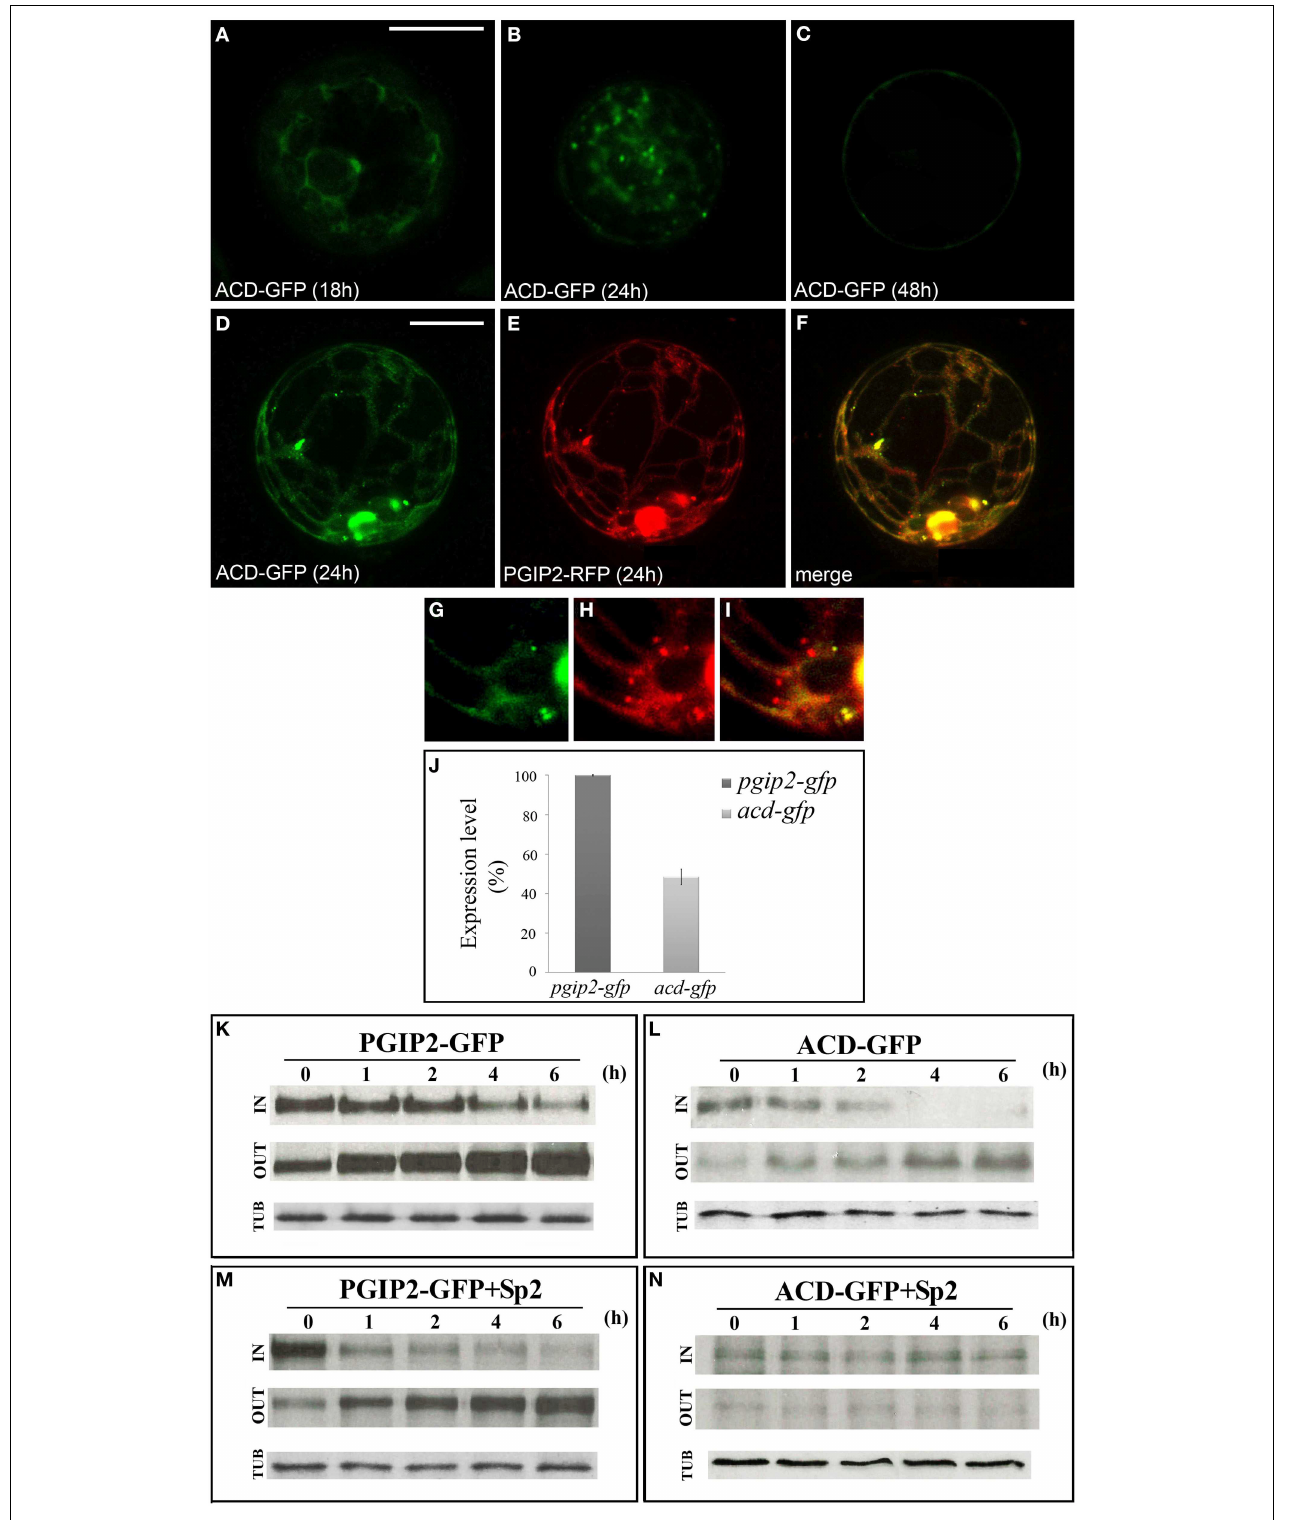
FIGURE 5 | PGIP2 depleted of B domain (ACD-GFP) was expressed at low level and secreted by default. (A) ACD-GFP progressively labeled ER, (B) Golgi stacks, and (C) the cell wall. (D–I) Three-dimensional (3D) images of protoplasts co-expressing ACD-GFP (D,G) , PGIP2-RFP (E,H) and merged